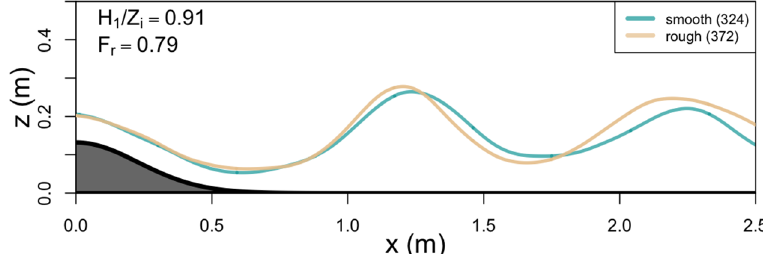
Figure 11. Interface displacement for two single obstacle runs with fixed H 1 /Z i = 0.91 and Fr = 0.79 but for a run with just the baseplate (smooth) and run with additional lego elements to increase the surface roughness (rough).